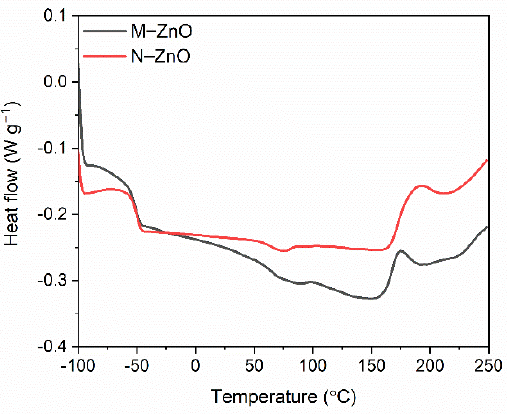
Figure 5. Differential Scanning Calorimetry (DSC) curves of SBR compounds containing M-ZnO and N-ZnO as activators.